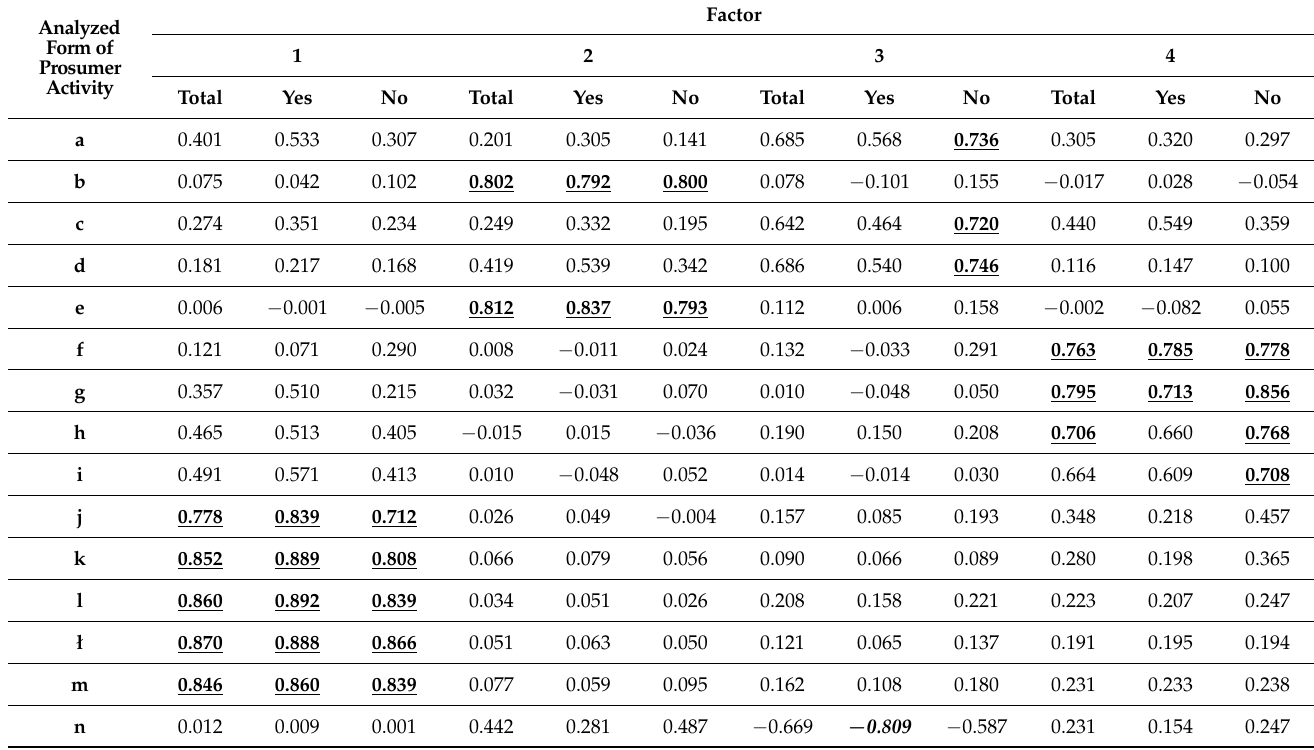
Table 6. Factor analysis for three groups of respondents (total respondents, respondents who positively perceived offerors, and respondents who negatively perceived